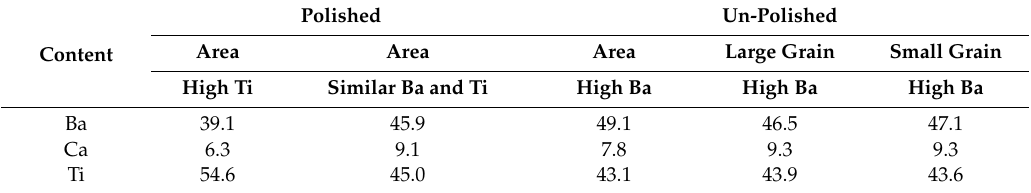
Table 2. Exemplar atomic concentration (at. %) estimated for cleaved Ba 0.83 Ca 0.17 TiO 3 ceramics surfaces. The nominal ratio is Ba:Ca:Ti = 41.5:8.5:50. The SEM signal was collected for large areas and for individual grains.